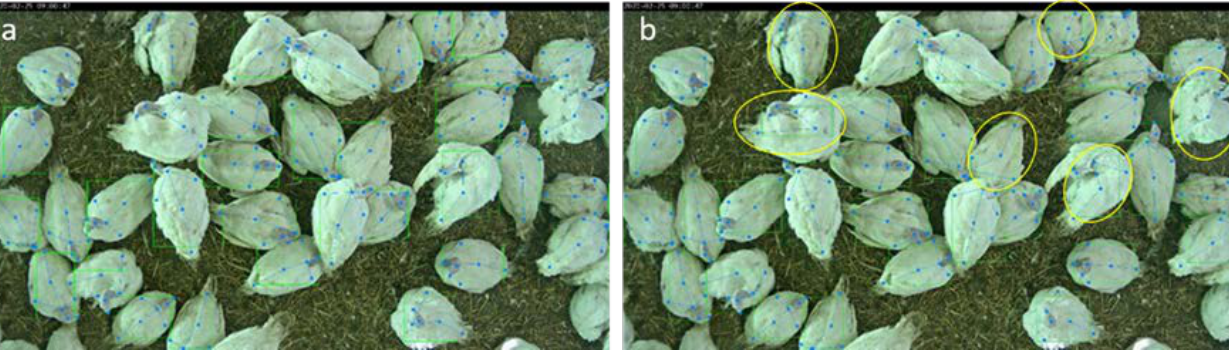
Figure 5. Comparison of KPD using ( a ) baseline method with 152 layers and ( b ) HRNet-W48. Turkeys showing differences between the results of the baseline and HRNet are highlighted with yellow circles on the right image.